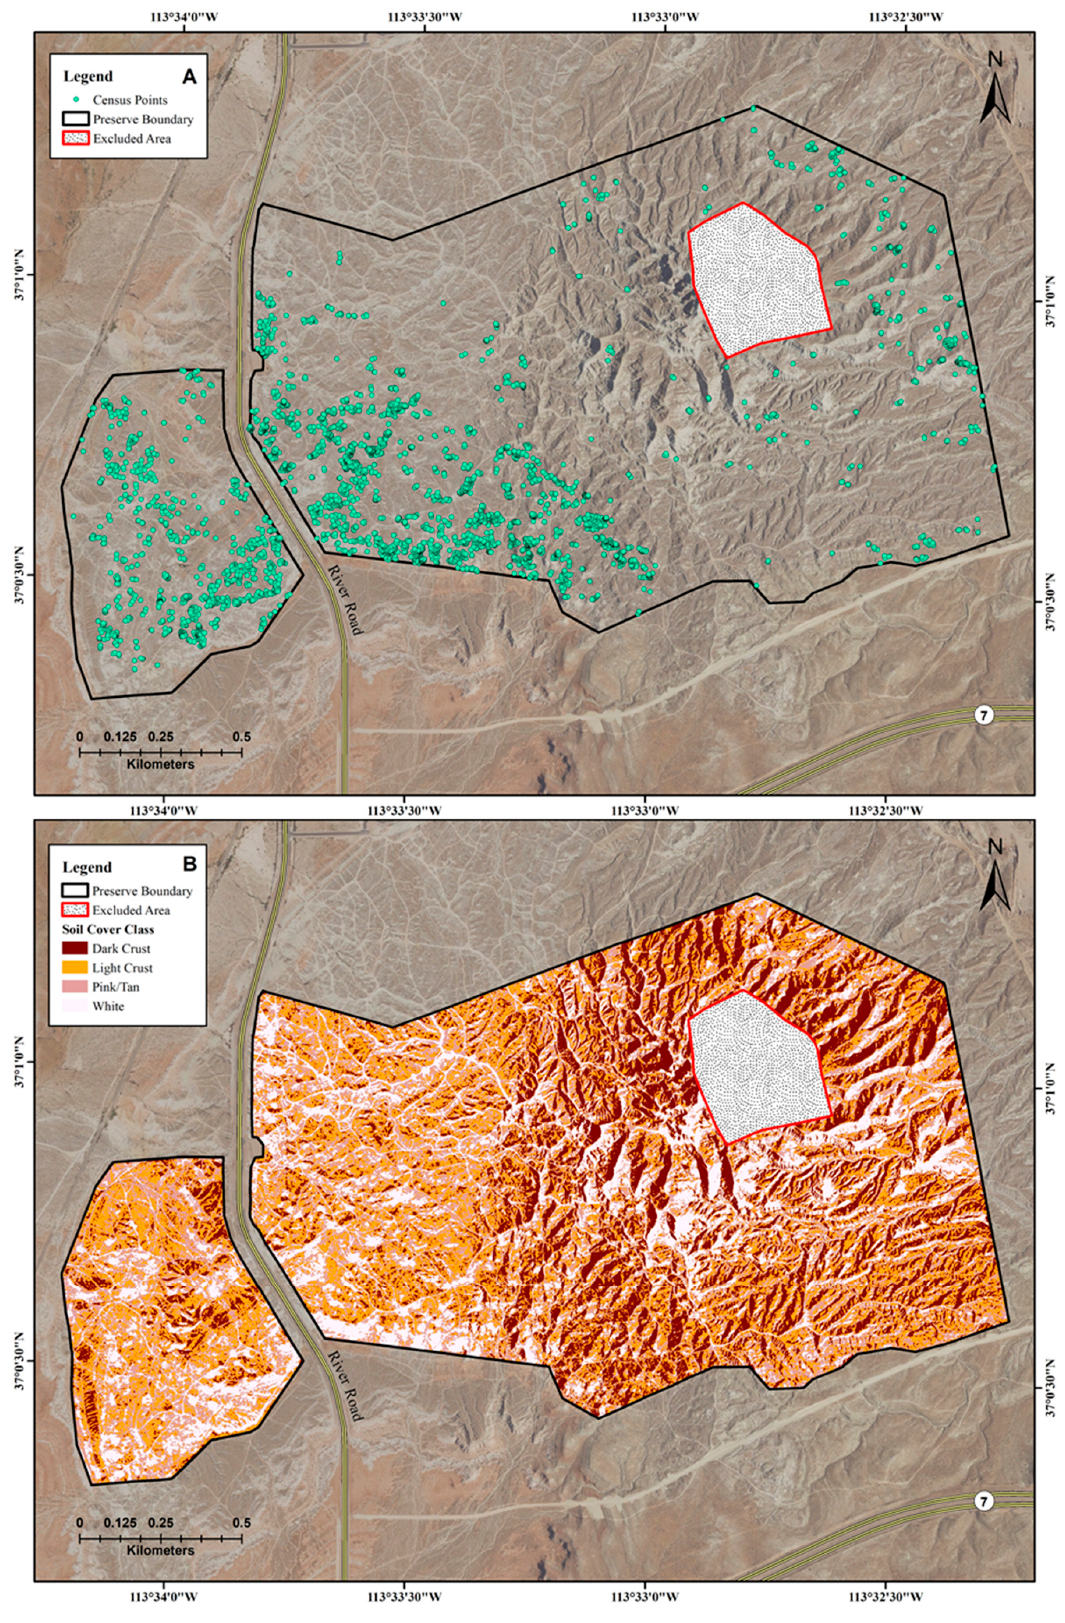
Figure 3. ( A ) Census of White Dome Nature Preserve (green points represent marked plants within the 50-m imagery); ( B ) ISO-cluster classification of White Dome using 1-m NAIP (National Agricultural Imagery Program) imagery.